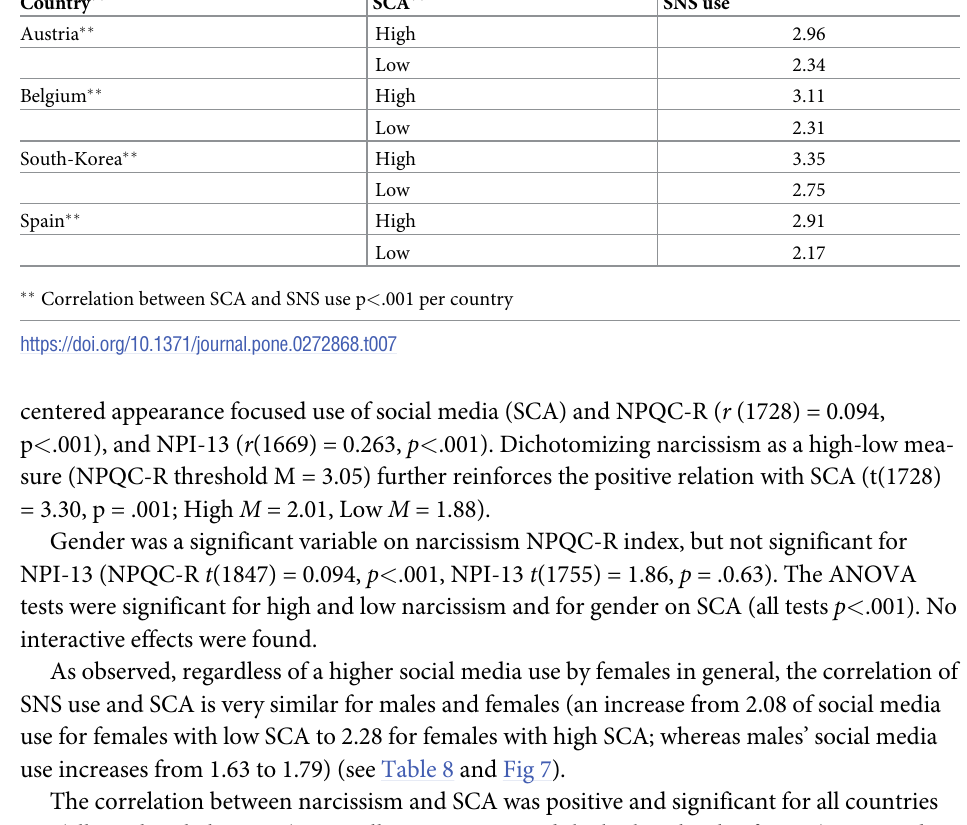
Table 7. Social media use (SNS use) by country, and level of narcissism. Country ��